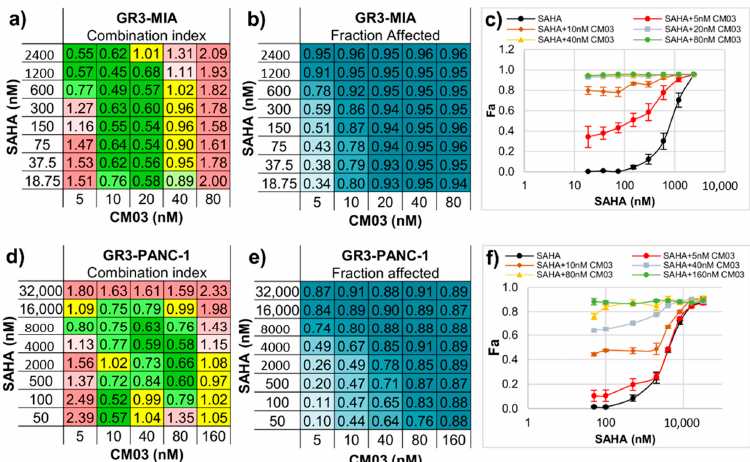
Figure 3. Synergistic e ff ect between CM03 and SAHA in gemcitabine-resistant (GR) Pancreatic Ductal AdenoCarcinoma (PDAC) cell lines. ( a , d ) Combination index (CI) values for the drug combination between SAHA and CM03 in ( a ) GR3-MIA and ( d ) GR 3 µ M PNAC-1 cell lines, CI < 1 indicates synergism (green), CI = 1 additive e ff ect (yellow) and CI > 1 antagonism (red). ( b , e ) Fraction a ff ected (Fa) by different combinations of drugs’ concentrations in ( b ) GR3-MIA and ( e ) GR 3µM PNAC-1 cell lines using SRB cytotoxicity assay. ( c , f ) Dose–response curves for SAHA alone and in combination with CM03 in ( c ) MIA PaCa-2 and ( f ) PNAC-1 cell lines. Data represents the mean ± SEM of at least three independent experiments. The drug combination between SAHA and CM03 also shows a synergistic induction of apoptosis Molecules 2020 , 25 , x FOR PEER REVIEW and DNA damage in the wild-type MIA PaCa-2 and PANC-1 cell lines, based on immunoblotting analysis of markers for apoptosis and DNA damage (Figure 4). Higher (though broadly equivalent) concentrations were used in these experiments, with shorter cell exposures than in the combination index experiments. Equivalent results were obtained in both cell lines and show that whereas neither CM03 nor SAHA alone produce significant evidence of apoptosis, as shown by low levels of the PARP apoptosis marker; in combination, the increase in levels of PARP is significant at a >99.9% level, as judged by the one-way ANOVA test. The changes in PANC-1 cells are especially notable, and accordingly, this line was used to examine changes in the levels of the DNA damage marker γ -H2AX. Figure 4e shows that the combination alone produces a statistically significant increase in γ -H2AX levels.